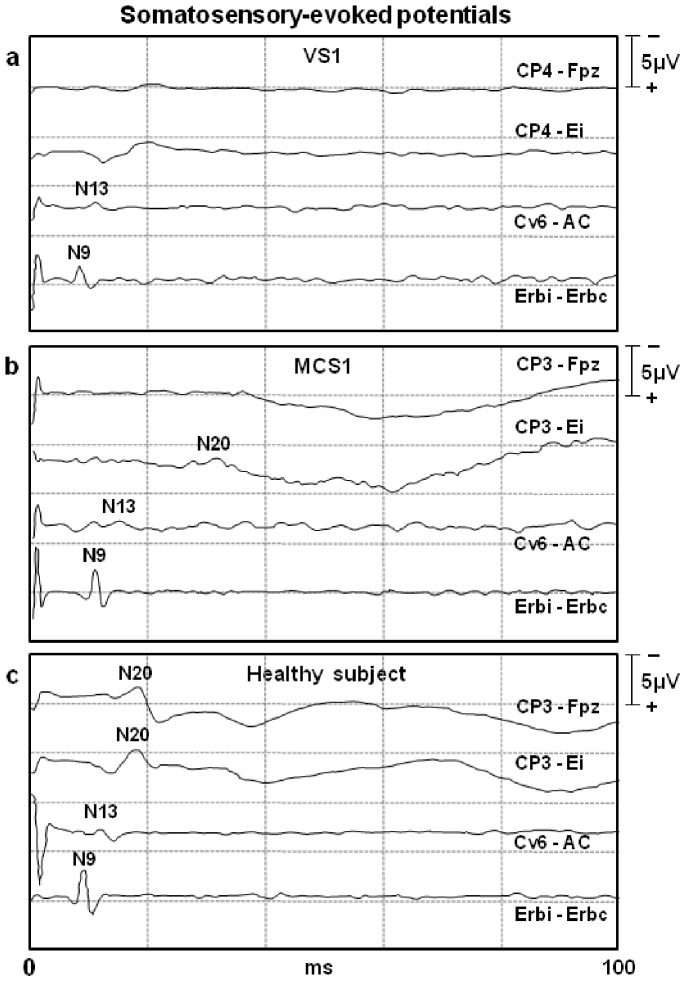
Representative short-latency median nerve somatosensory-evoked potential (SEPs) tracings in one VS1 (a) patient, one MCS1 (b) patient, and one normal (c) subject.In the VS patient, the electrical stimulation at the wrist elicited the activation of the brachial plexus at Erb’s point (wave N9) and of the cervical spine (wave N13) with normal amplitude/latency characteristics. Even the subcortical far-field P14 wave was recordable, while no cortical activation was detectable (i.e., absence of N20 wave) in the contralateral somatosensory cortex of the VS1 patient. In patient MCS1, the SEPs were abnormal, as the cortical component N20 was delayed and of a very small amplitude (<0.7 µV) and was only detected with the earlobe-reference montage. CP3/CP4: parietal scalp electrodes contralateral to stimulation; Fz: reference mid-frontal scalp electrode; Ei: reference electrode on the earlobe ipsilateral to stimulation; Cv6: posterior spinal cervical electrode over the 6th cervical spinous process; AC: anterior neck reference electrode; Erbi/Erbc: clavicle Erb’s point electrodes, ipsilateral or contralateral to stimulation.